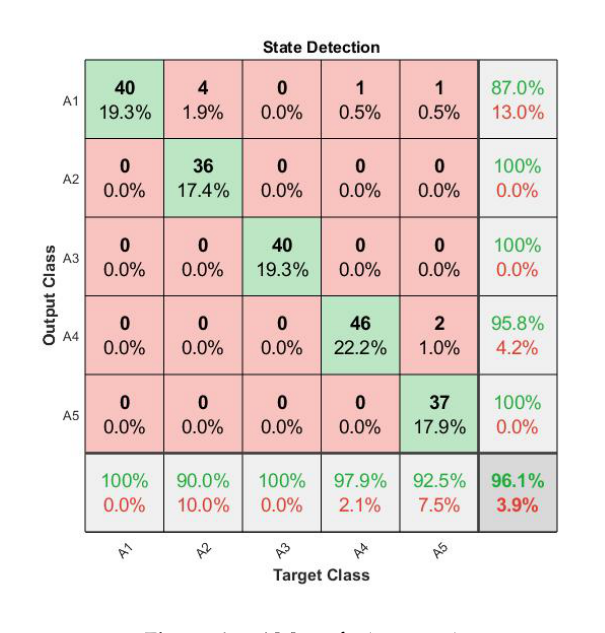
Figure A5. AM confusion matrix.